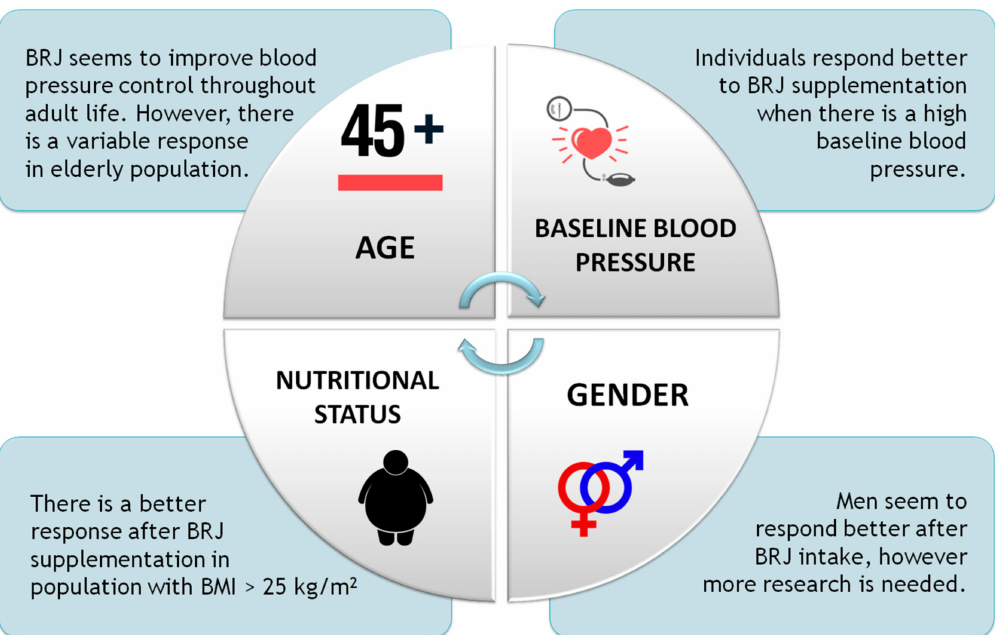
Figure 4. Individual factors influencing the effects of BRJ supplementation on blood